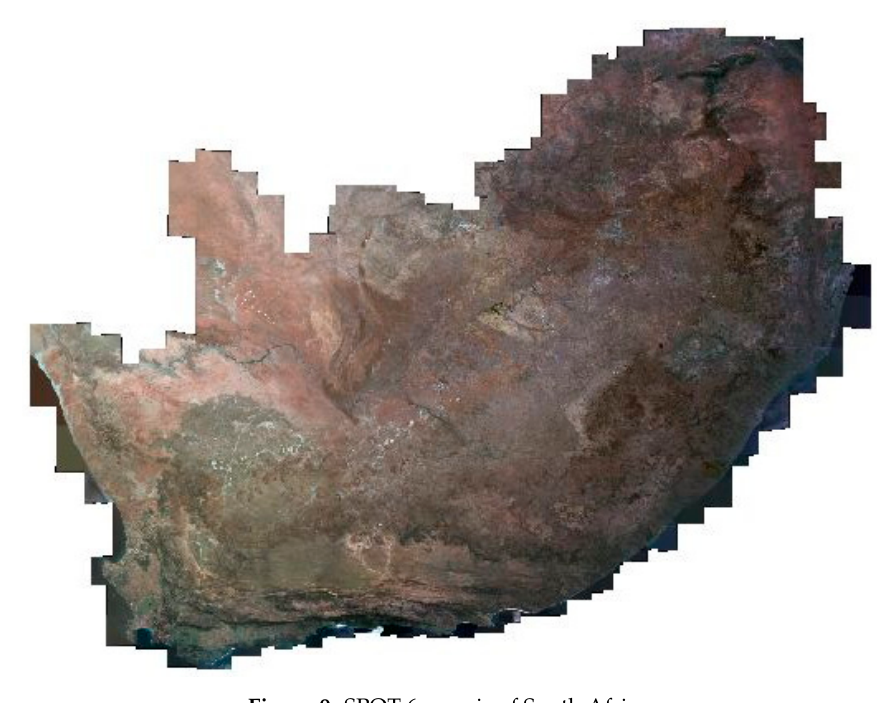
Figure 9. SPOT 6 mosaic of South Africa.